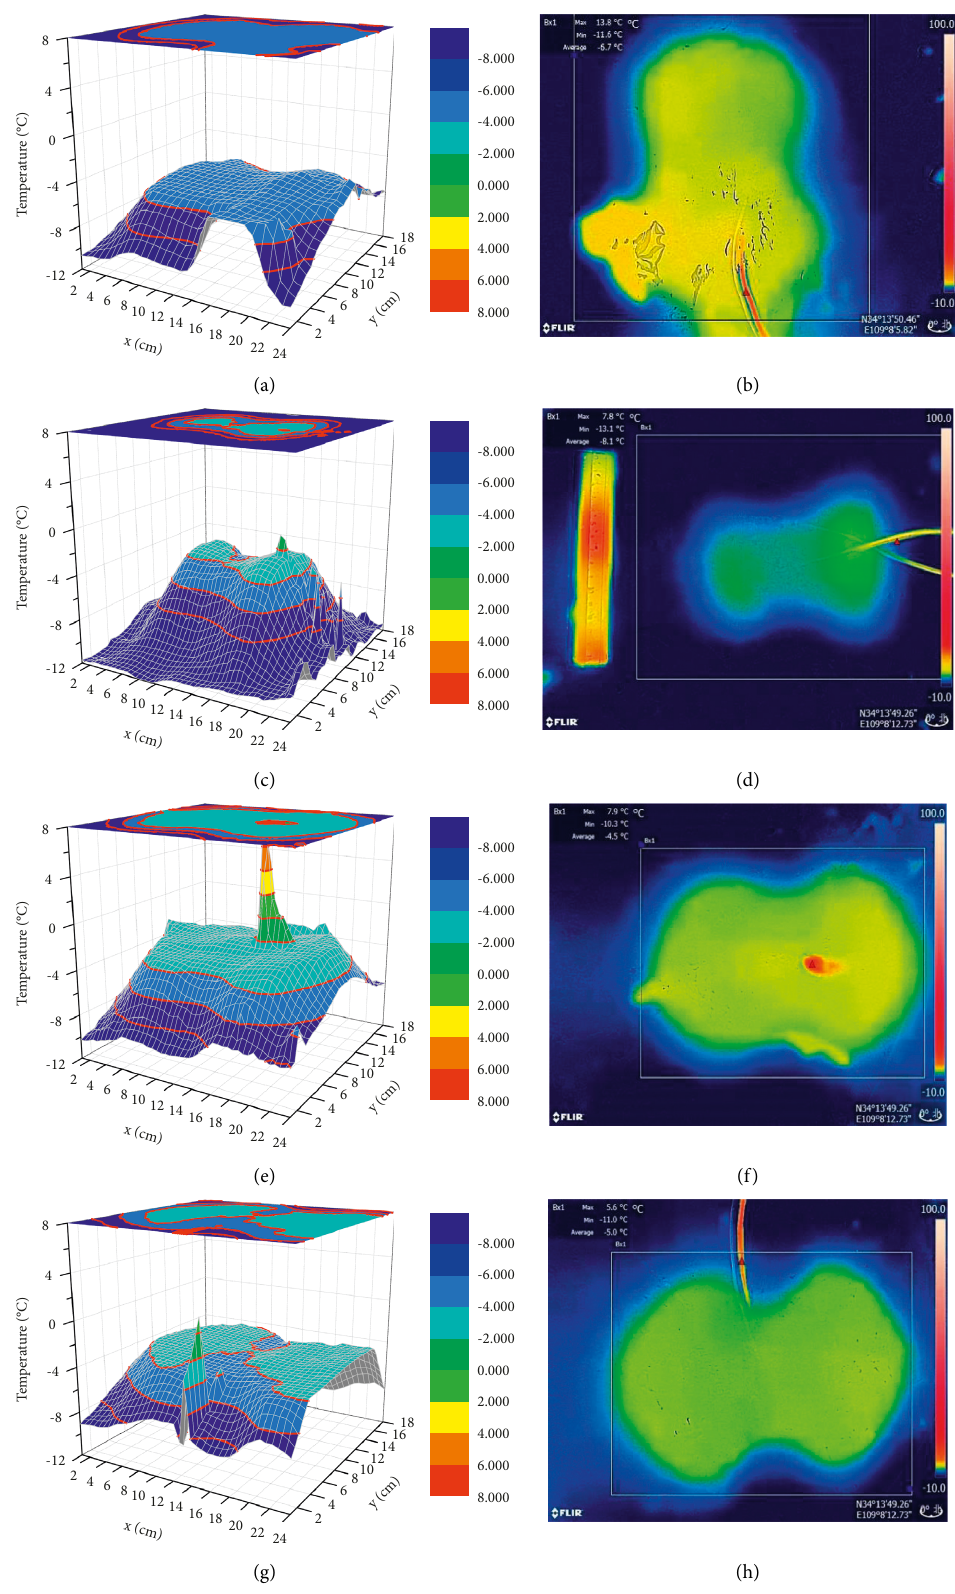
Figure 13: 3D stereogram and IR thermogram of surface temperature at different lengths. (a) PC-1. (b) PC-2. (c) 0.1CFC3-1. (d) 0.1CFC3-2. (e) 0.3CFC3-1. (f) 0.3CFC3-2. (g) 0.6CFC3-1. (h)